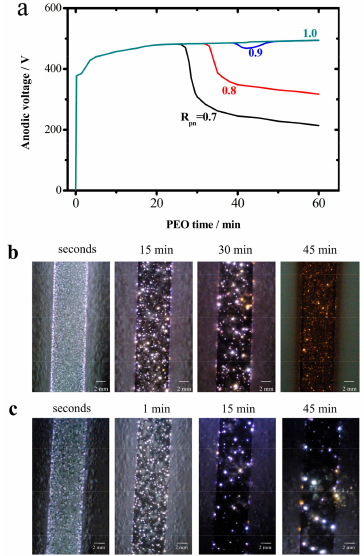
Figure 2. Soft sparking transitions in anodic voltage and light emission. A voltage–time graph shows ( a ) two pronounced anodic voltage drops out of four PEO operations with R pn = 0.7, 0.8, 0.9, 1.0 in a prototype solution [40]. ( b ) A time-series of photos show the plasma state changed suddenly between 35 and 45 min with R pn = 0.89. In contrast, ( c ) another series of photos show the regular plasma state persisted throughout 45 min with R pn = 1.57